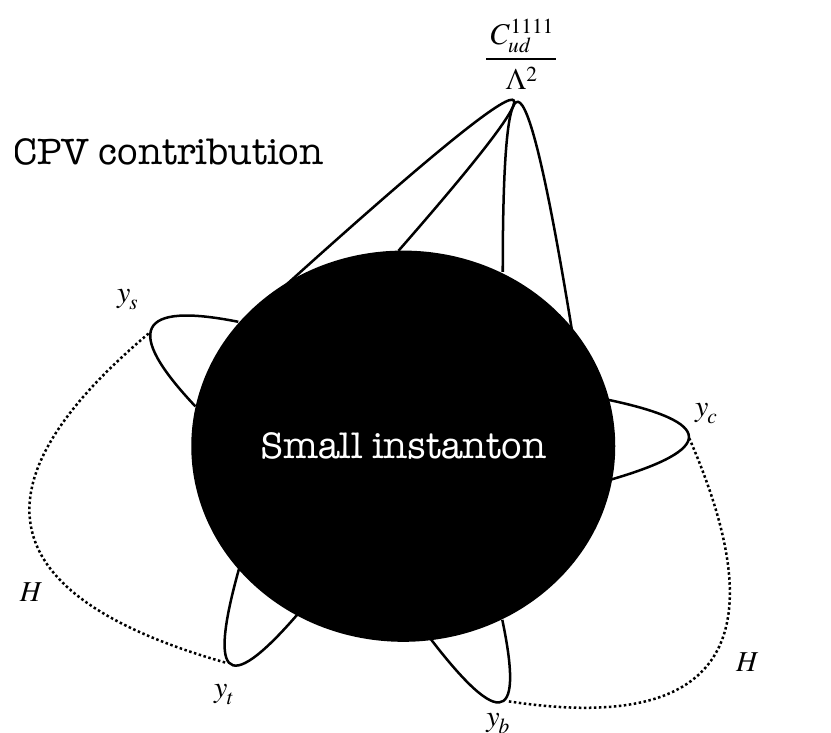
Figure 2 . One of the small instanton diagrams that gives a new CP phase to the axion